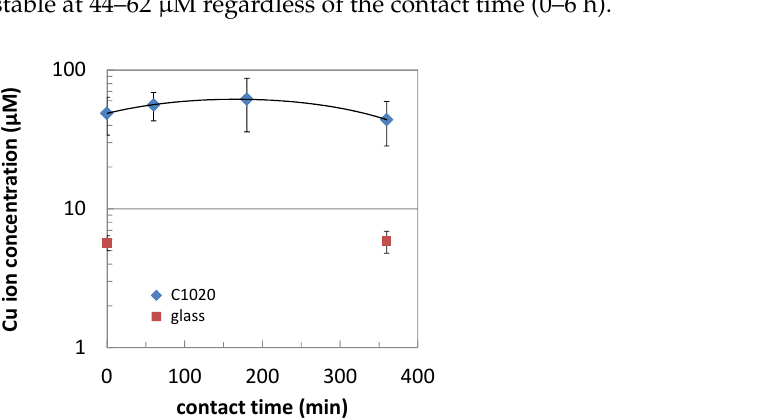
Figure 4. Nucleic acid remaining rates measured at 5 min after adding a certain concentration of CuCl or CuCl 2 (mean ± standard deviation).